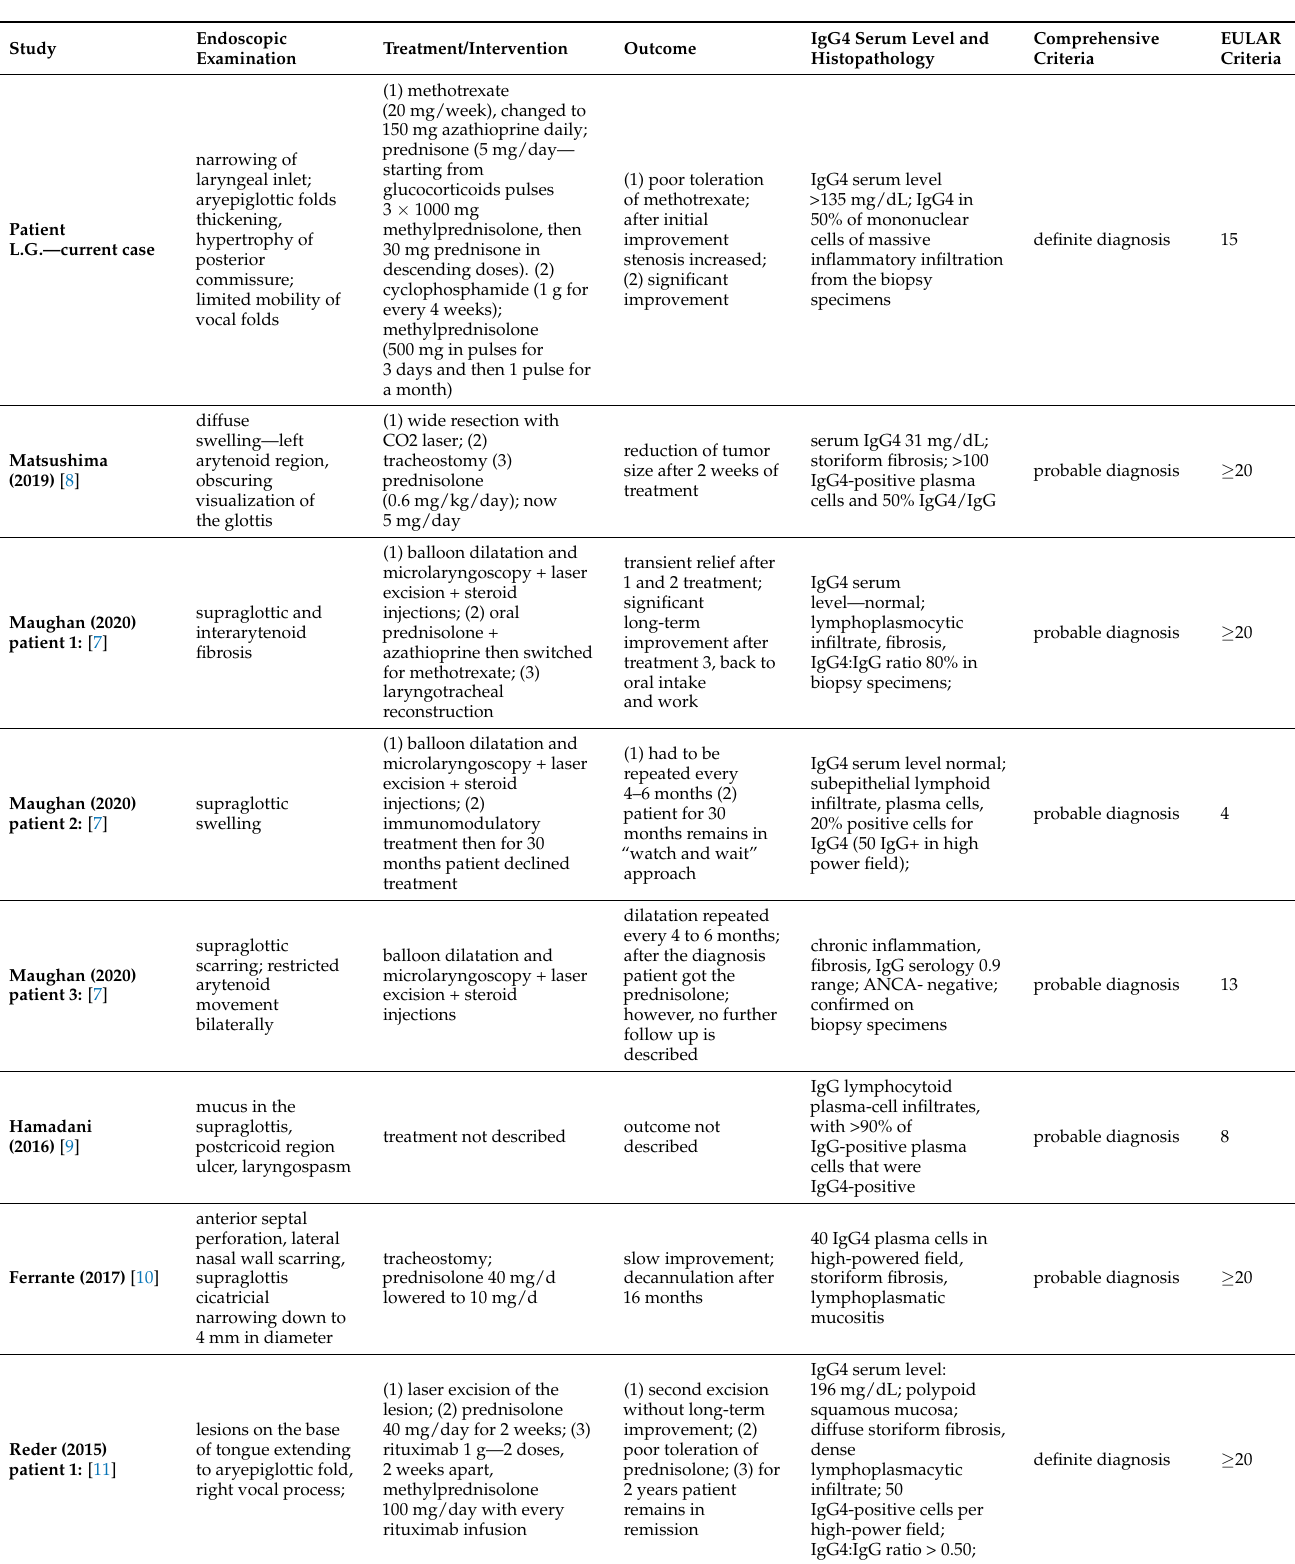
Table A1. Detailed diagnosis, treatment and outcome of the reviewed